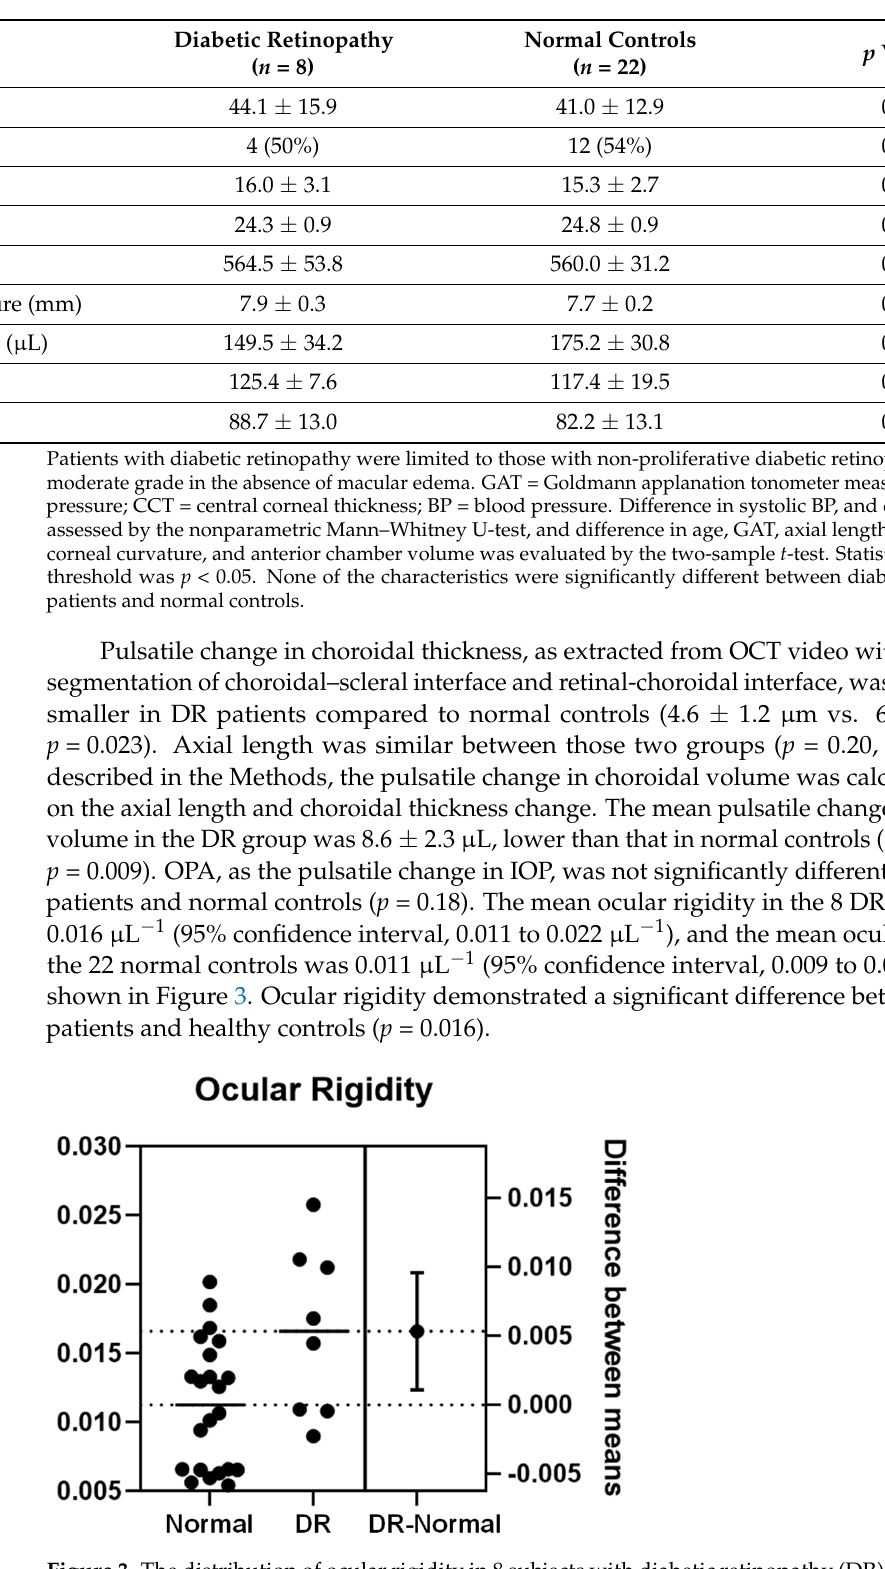
Table 1. The clinical characteristics of all participants ( n = 30) and their statistical distribution.